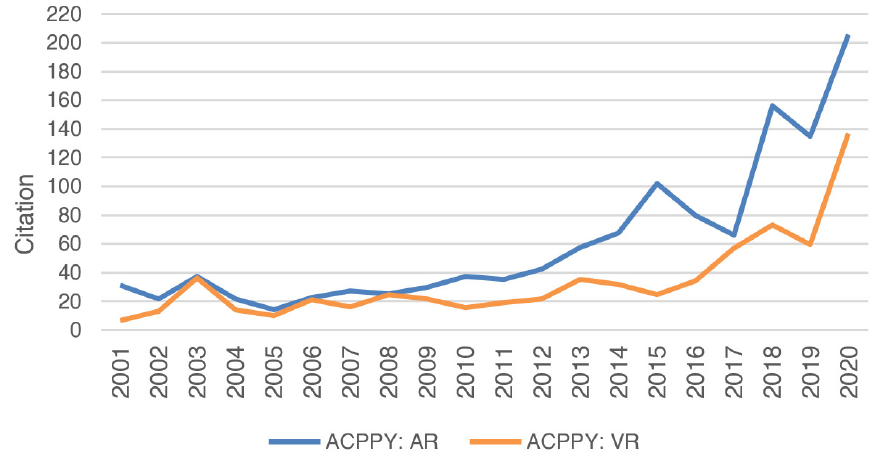
Fig. 7. Average citation per paper per